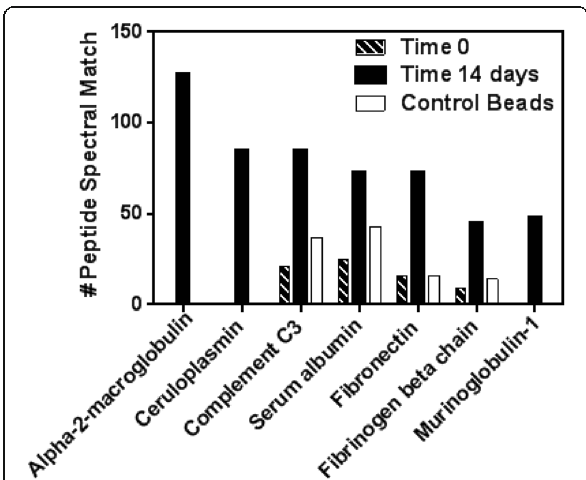
Fig. 4 Anti-CD74-Phos-Bud-interacting proteins in C57BL/6 J plasma. To determine any off-target protein binding, Anti-CD74-Phos-Bud was incubated in C57BL/6 J mouse plasma for 14 days at 37 °C and retrieved by pull-down. Pulled-down products were digested with trypsin and analyzed by LC-MS/MS for peptide mapping. Data represent the results of a single incubation at each time